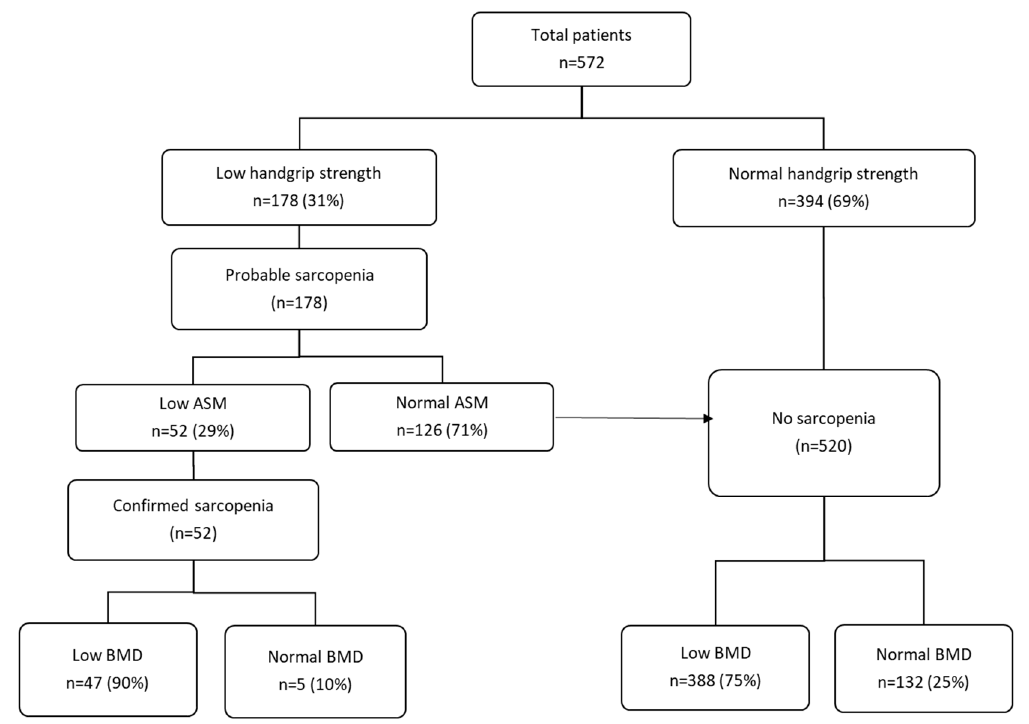
Figure 1. Identifying patients with sarcopenia and low BMD in total population (n = 572). ASM, appendicular skeletal muscle mass; BMD, bone mineral density. Sarcopenia is probable when low muscle strength, as measured by handgrip strength, is detected. A sarcopenia diagnosis is confirmed by the presence of low ASM, as measured by DXA and low muscle strength. Patients with normal handgrip strength and normal ASM were classified as non-sarcopenic.